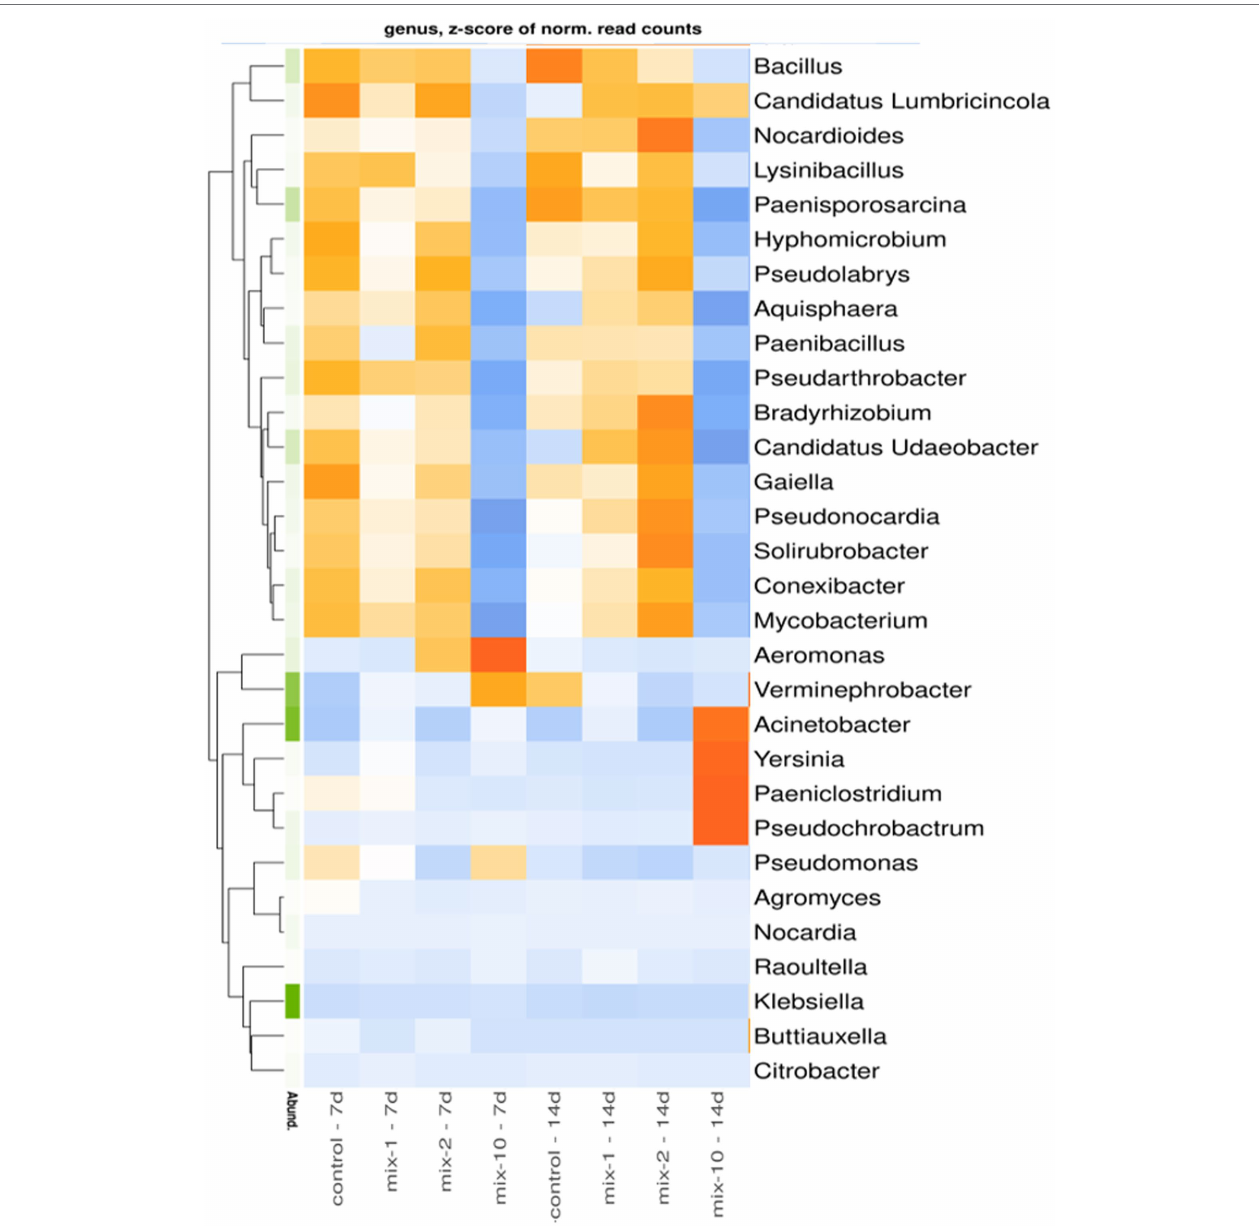
FIGURE 4 | Heatmap for relative abundance of top 30 microbial taxa in prokaryotic communities of the earthworm’s guts at the genus level ( N = 2). The data are presented as z -scores. Microbial genera with positive z -scores are marked in orange, genera with negative z -scores in blue. Legend: mix indicates pesticides in a mixture; 1/2/10 is the recommended, 2-fold and 10-fold pesticide application rates; 7 day/14 day is the incubation time.